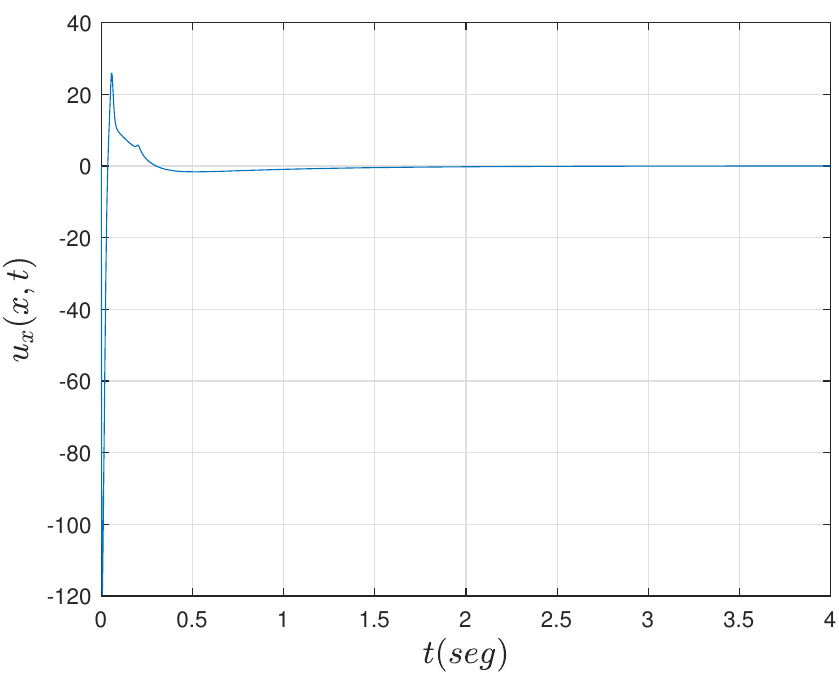
Figure 11. Control effort of the adaptive Neumann stabilizing